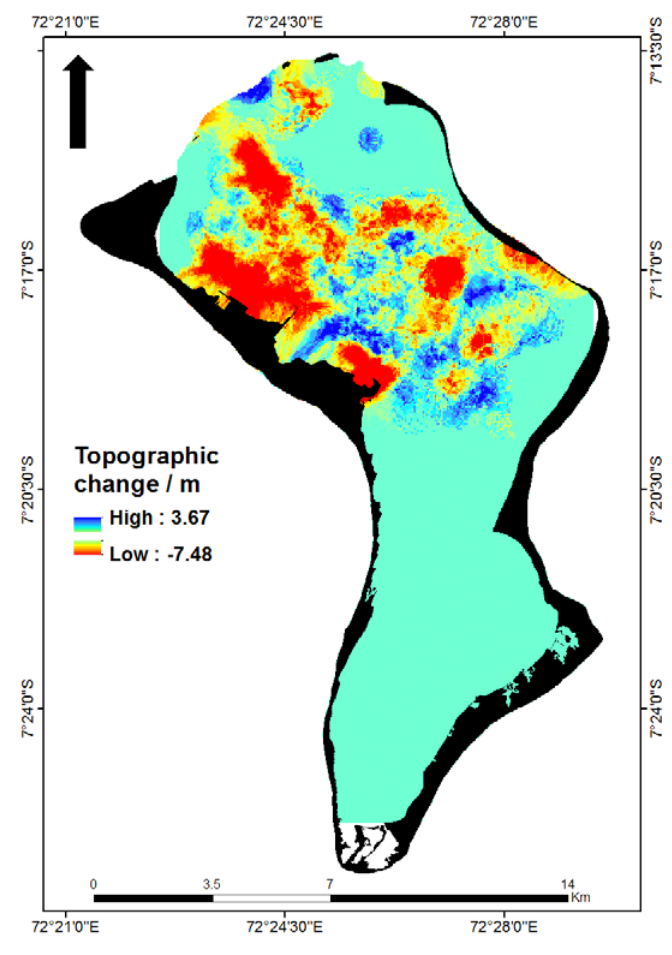
UK hydrographic survey data (1998) from that collected by the H.M.S. Vidal survey (1967). Red indicates sediment removal, blue indicates accretion and turquoise indicates no